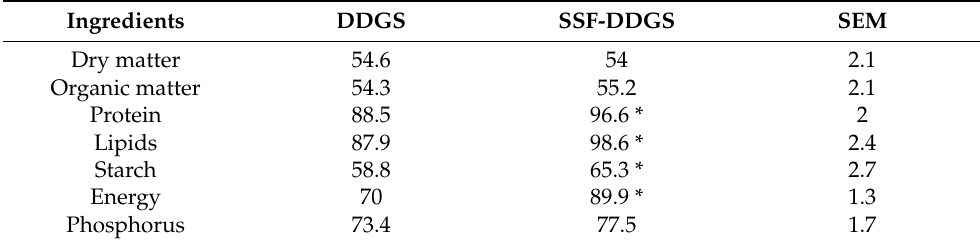
Table 5. Apparent digestibility coefficients (%) of distiller’s dried grains with solubles (DDGS) and solid-state fermented distiller’s dried grains with solubles (SSF-DDGS) with Aspergillus ibericus .